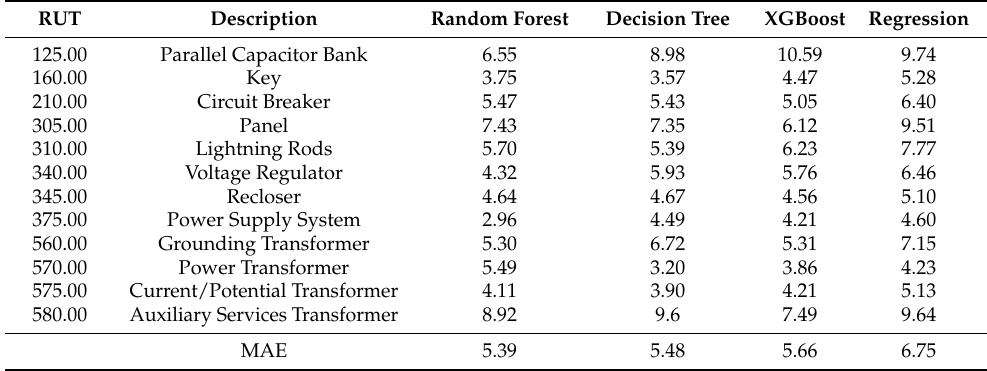
Table 1. Performance of ML algorithms by RUT.